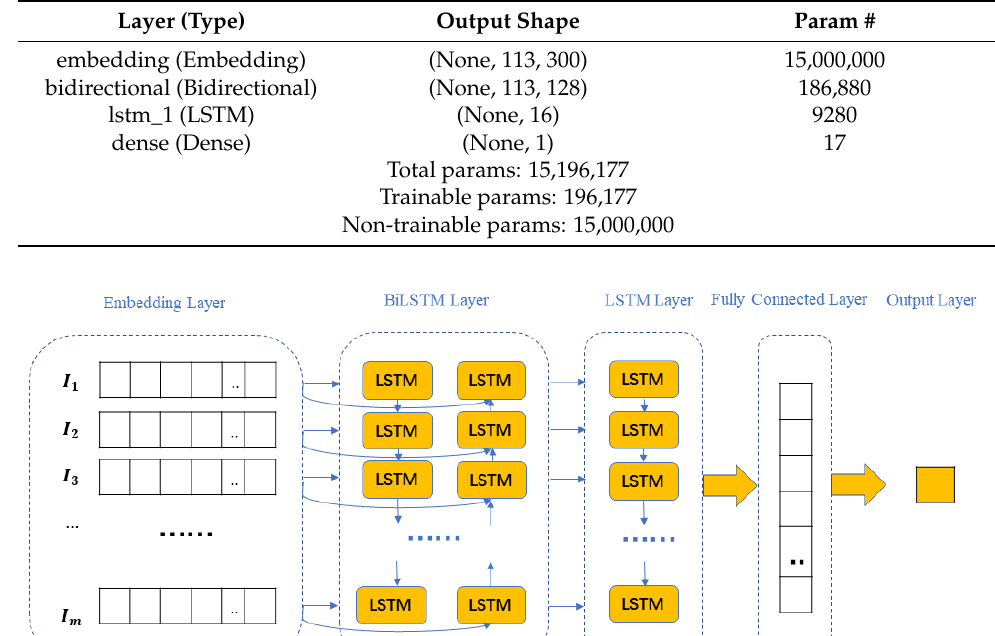
Table 1. Model architecture parameters.